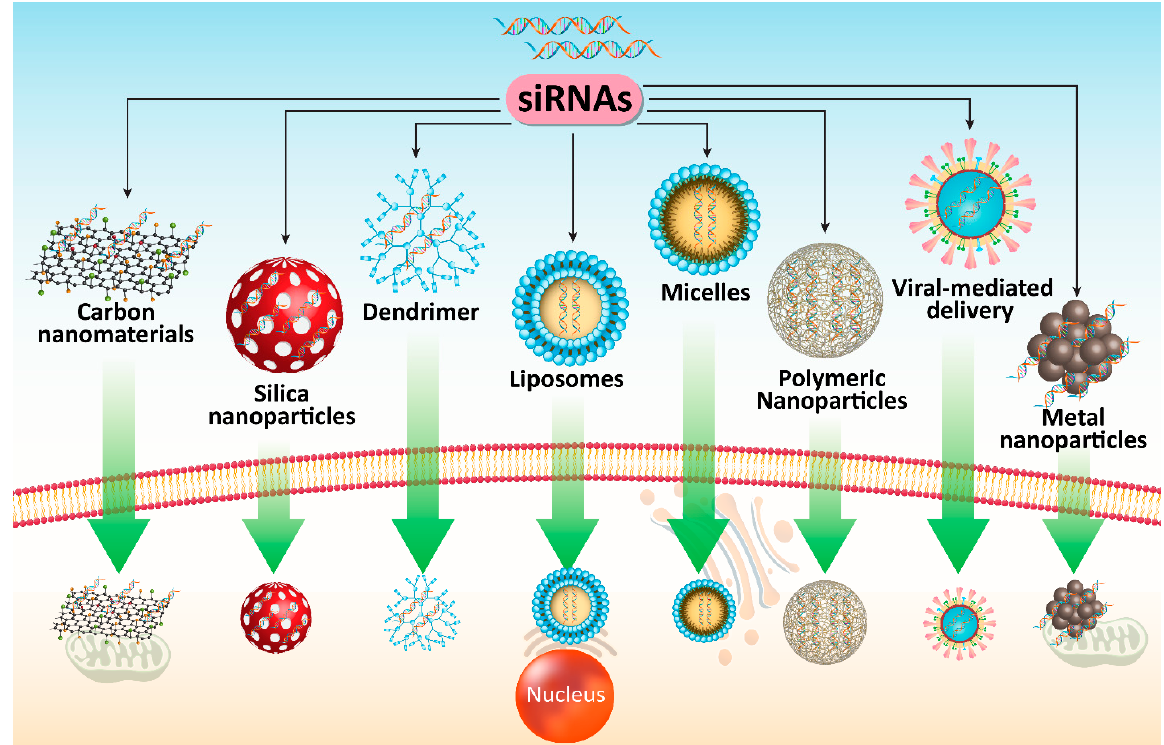
Figure 4. Different co-delivery systems for siRNA in PC therapy. Enhancing intracellular accumulation, protecting against degradation and increasing efficacy for gene silencing can be obtained using viral and non-viral vectors. SiRNA, small interfering RNA; PC, prostate cancer.